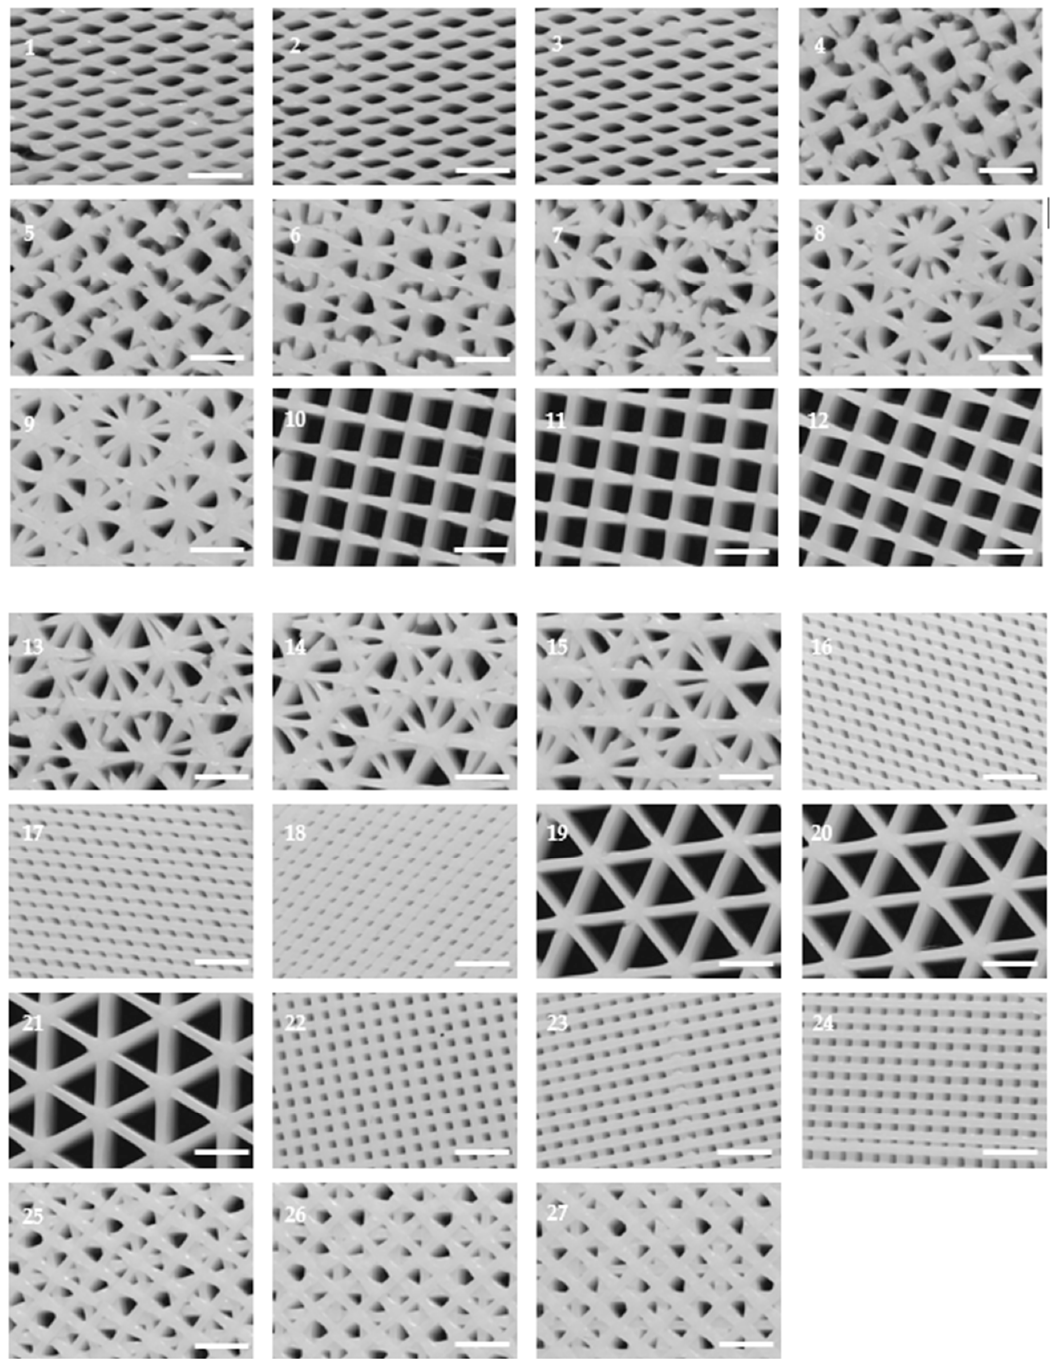
Figure 1. Microscopic characterization of PLA scaffold configurations. Top side was visualized under an optical microscope and images were used to calculate pore area and filament diameter. (Scale bar: 2 mm).